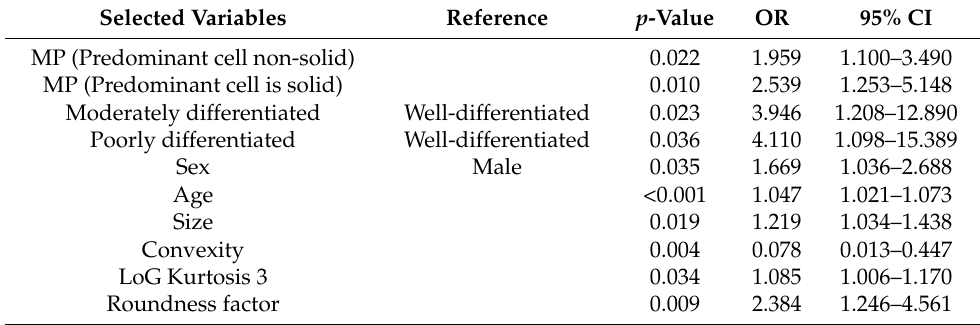
Table 2. Model integrating clinical features and radiomic margin characteristics for the prediction of overall survival (C-index: 0.753).